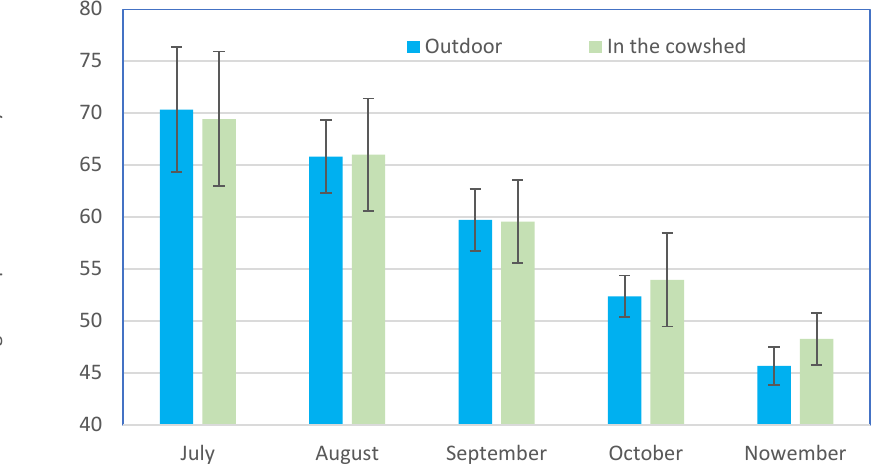
Figure 9. Average air temperature and humidity index in the different months (7 cowshed) .